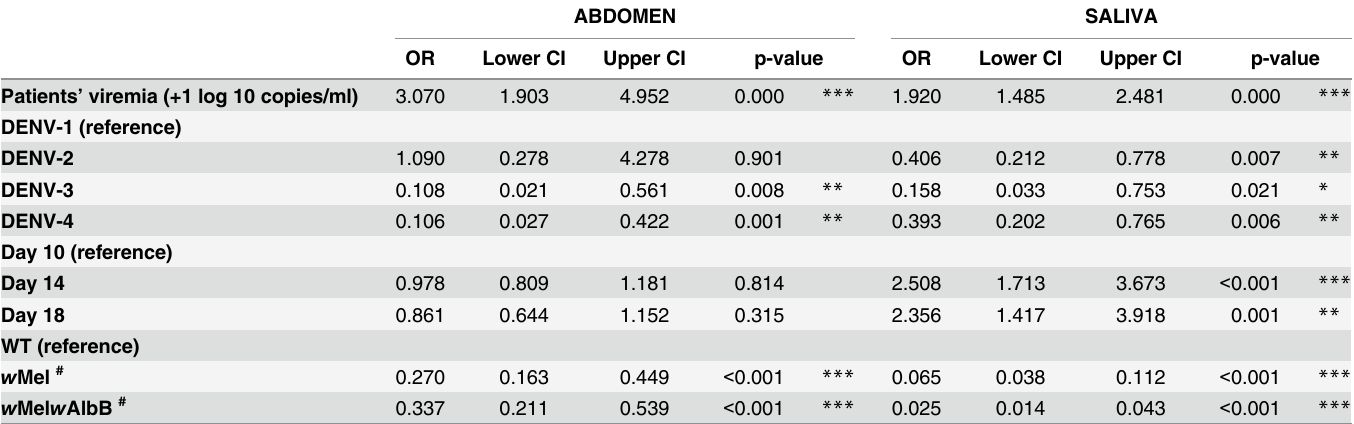
Table 3. Marginal logistic regression models for the risk of viral infection in the abdomen tissue, and for infectious saliva.